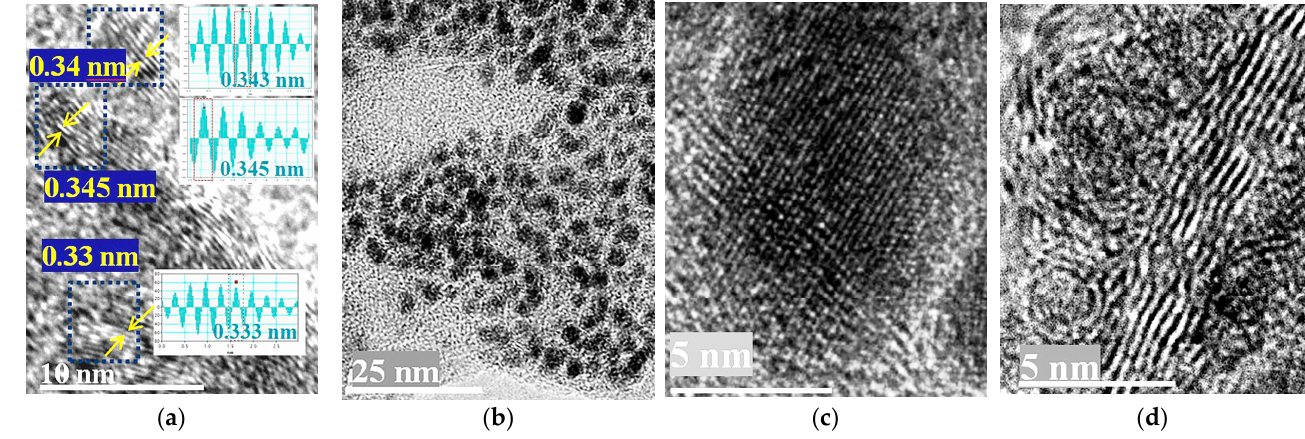
Figure 3. TEM images. ( a ) Interlayer spaces of the walls. ( b , c ) Graphene nanocrystallites inside the CNWs sample with a diameter around 9 nm. ( b ) In-plane lattice fringes. ( d ) Nanoparticles with curved layers inside the CNWs sample.